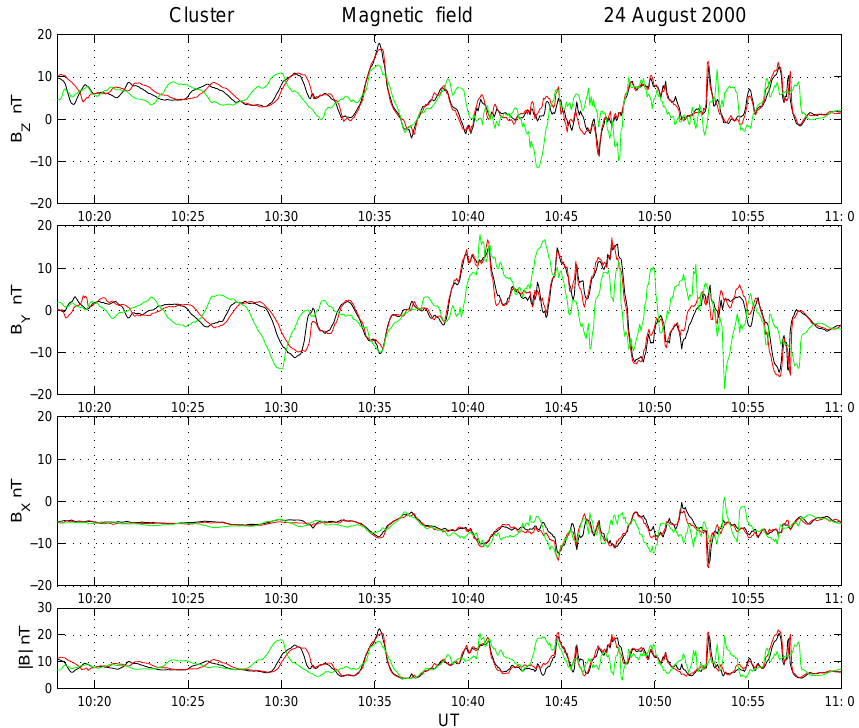
Fig. 7. The de-trended magnetic field components between 10:15 and 11:00UT on 24 August